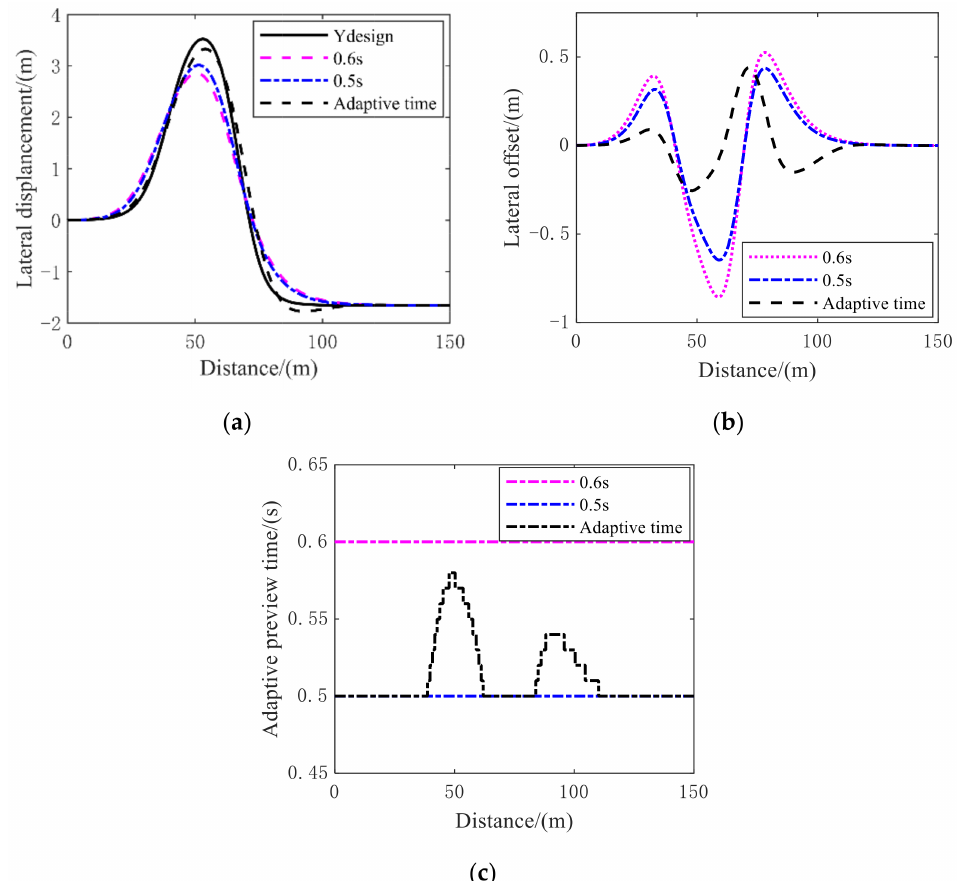
Figure 7. Comparation of fixed and adaptive preview times: ( a ) vehicle tracking path; ( b ) lateral offset; ( c ) preview